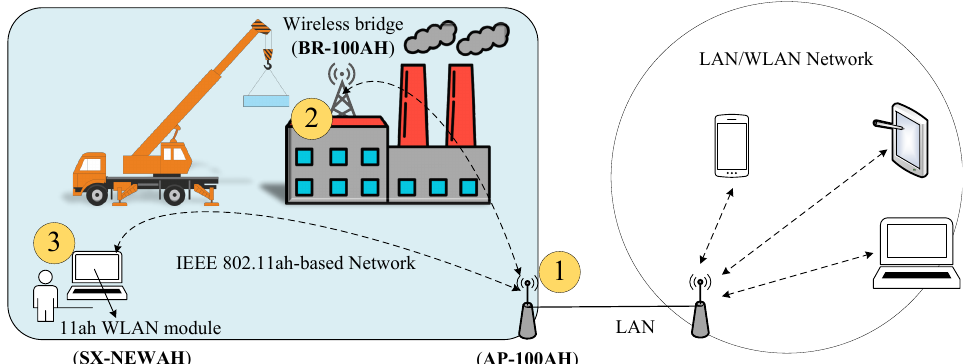
Figure 2. Use case of IEEE 802.11ah wireless bridge BR-100AH in industrial application [68]: (1)